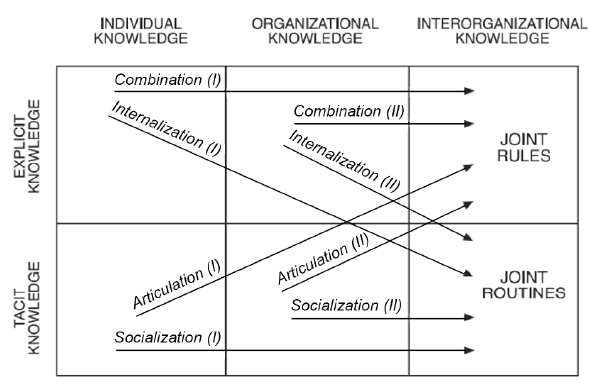
Fig. 1. Framework of learning in